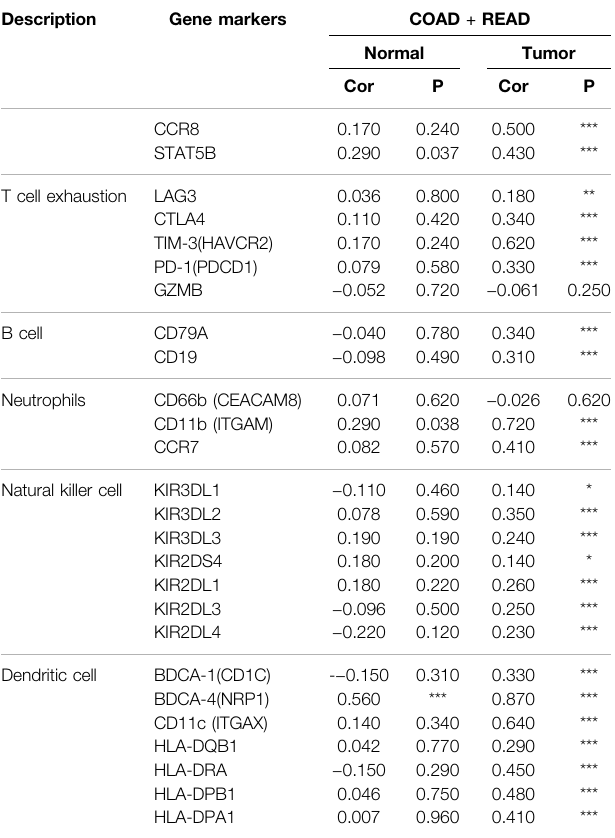
TABLE 2 | Correlation analysis between SEMA6B expression and related genes and markers of immune cells in normal tissues and CRC tissues by GEPIA. Description Gene markers